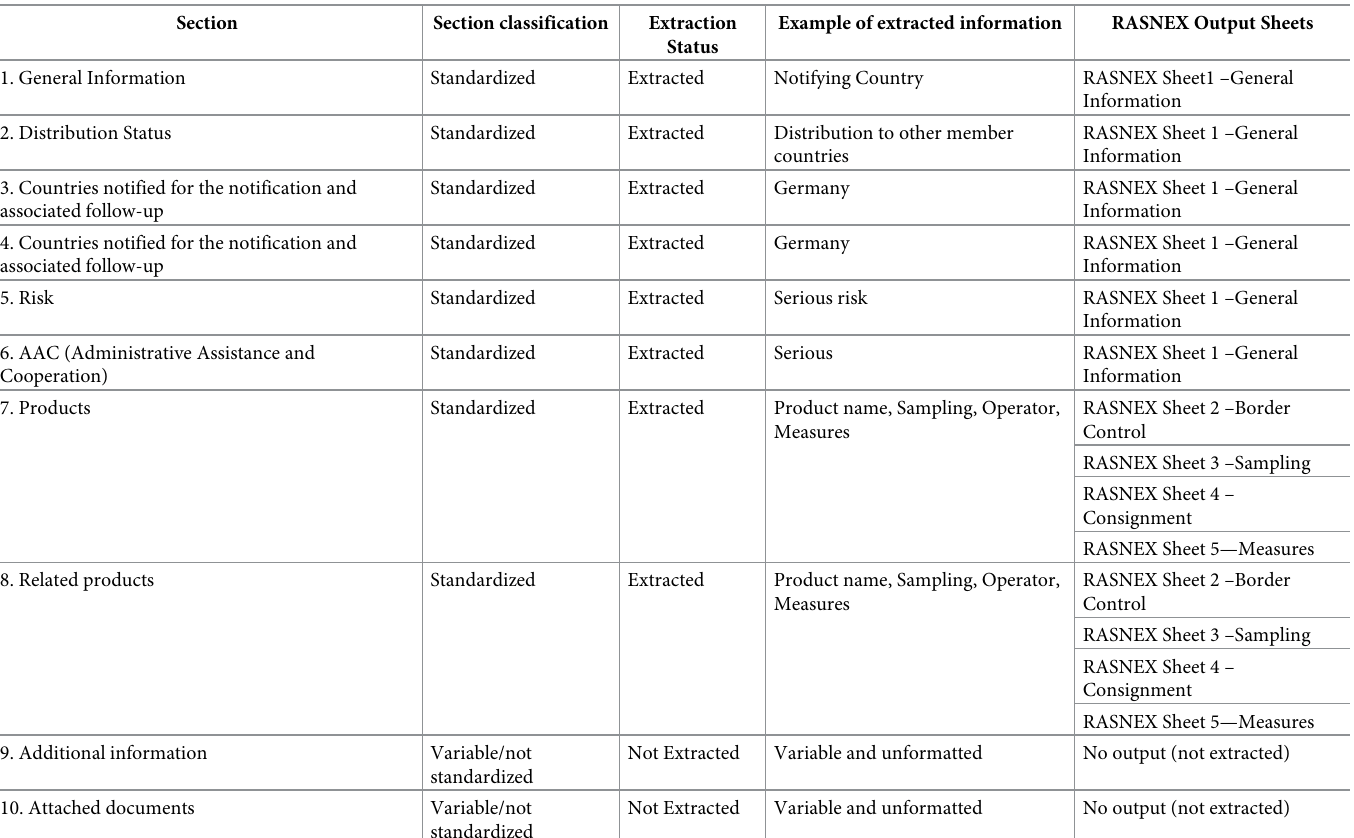
Table 1. Overview of the sections of a RASFF notification extracted and compiled as RASNEX 1.0 output Sheets 1–5.